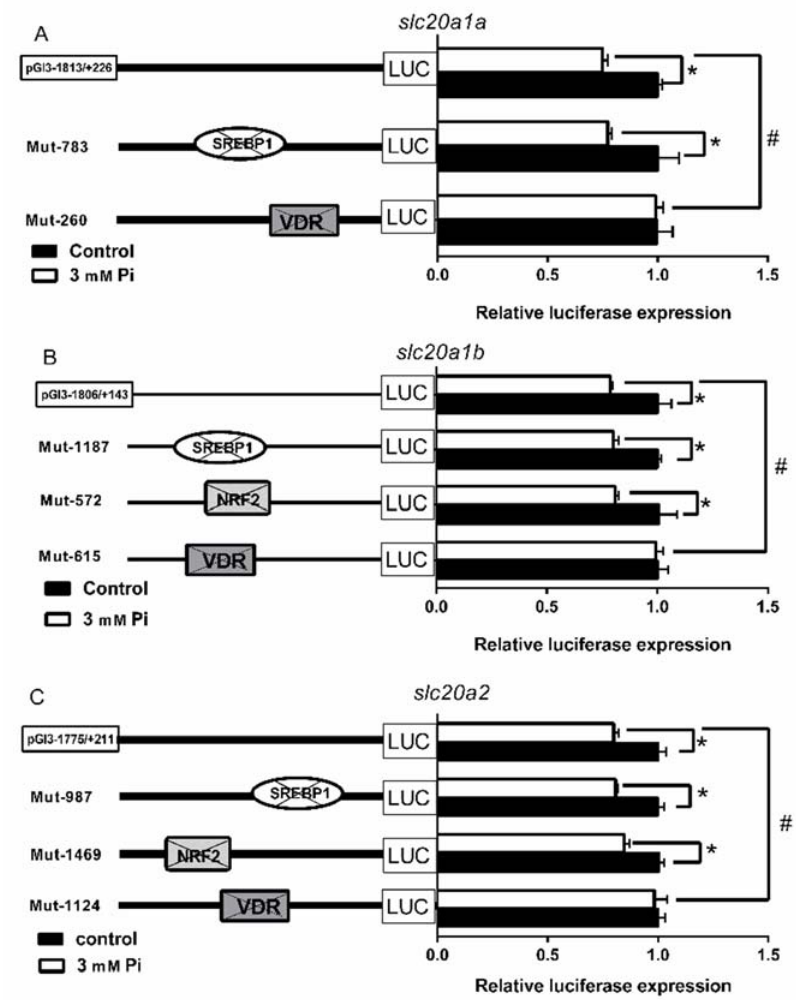
Figure 5. ( A ) Effect of Pi incubation on the promoter activities of slc20a1a after SREBP1 and VDR site mutagenesis. ( B ) Effect of Pi incubation on the promoter activities of slc20a1b after SREBP1, NRF2 VDR site mutagenesis. ( C ) E ff ect of Pi incubation on the promoter activities of slc20a2 after and VDR site mutagenesis. ( C ) Effect of Pi incubation on the promoter activities of slc20a2 after SREBP1, NRF2 and VDR site mutagenesis. Student’s t ‐ test was undertaken to detect the differences between two treatments. Asterisk (*) indicates significant differences between control and Pi treatment group in the same plasmid ( p < 0.05). Hash symbol (#) indicates significant differences between different 5 ′ unidirectional deletion plasmids under the same treatment ( p < 0.05).